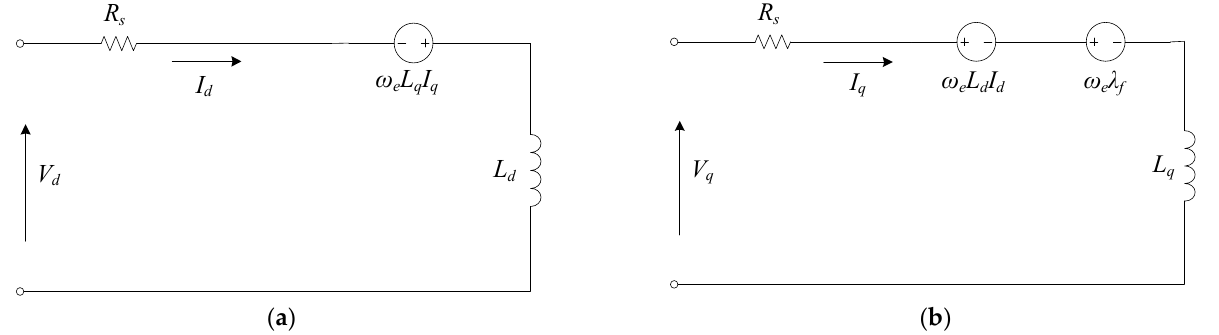
Figure 3. Conventional d - and q -axis ECMs of PMSM: ( a ) d -axis; ( b ) q -axis.